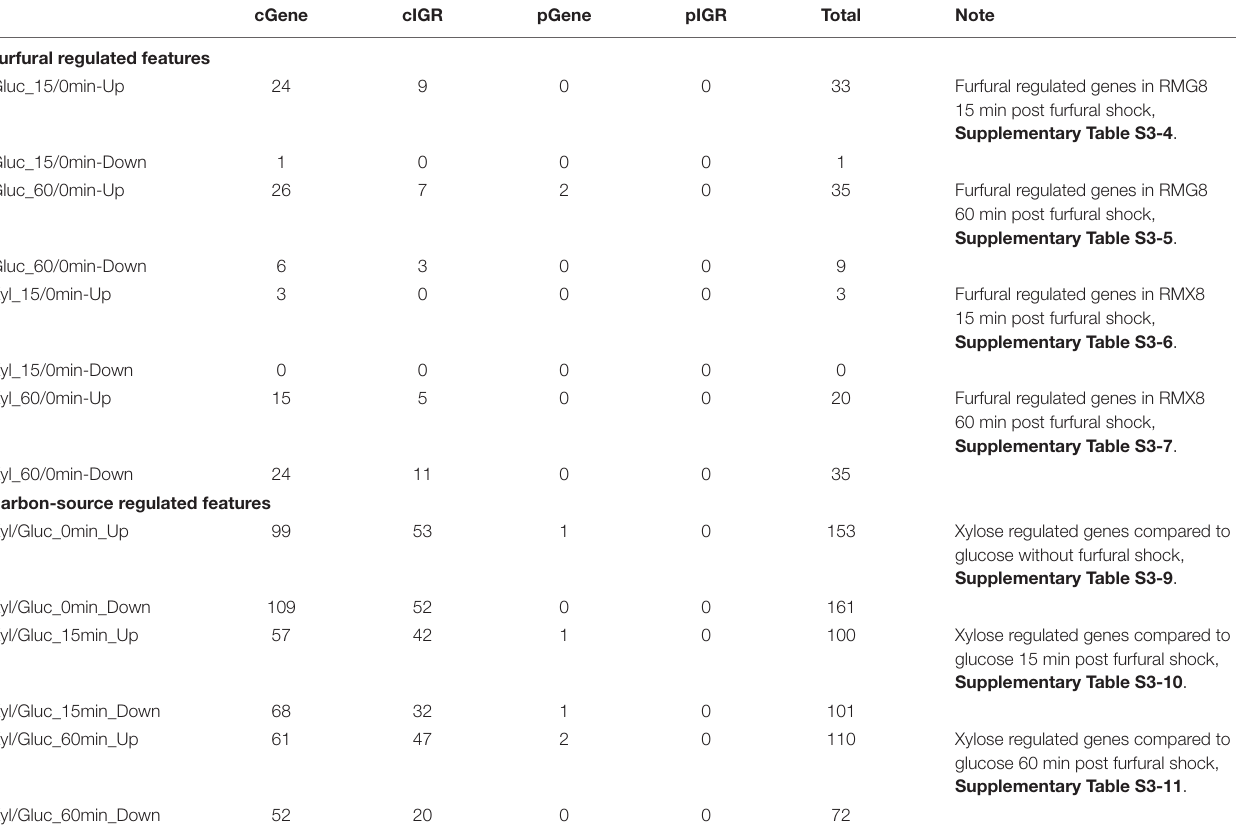
TABLE 2 | Summary of significantly differentially expressed genes in response to furfural or carbon sources in short-term shock response experiment.